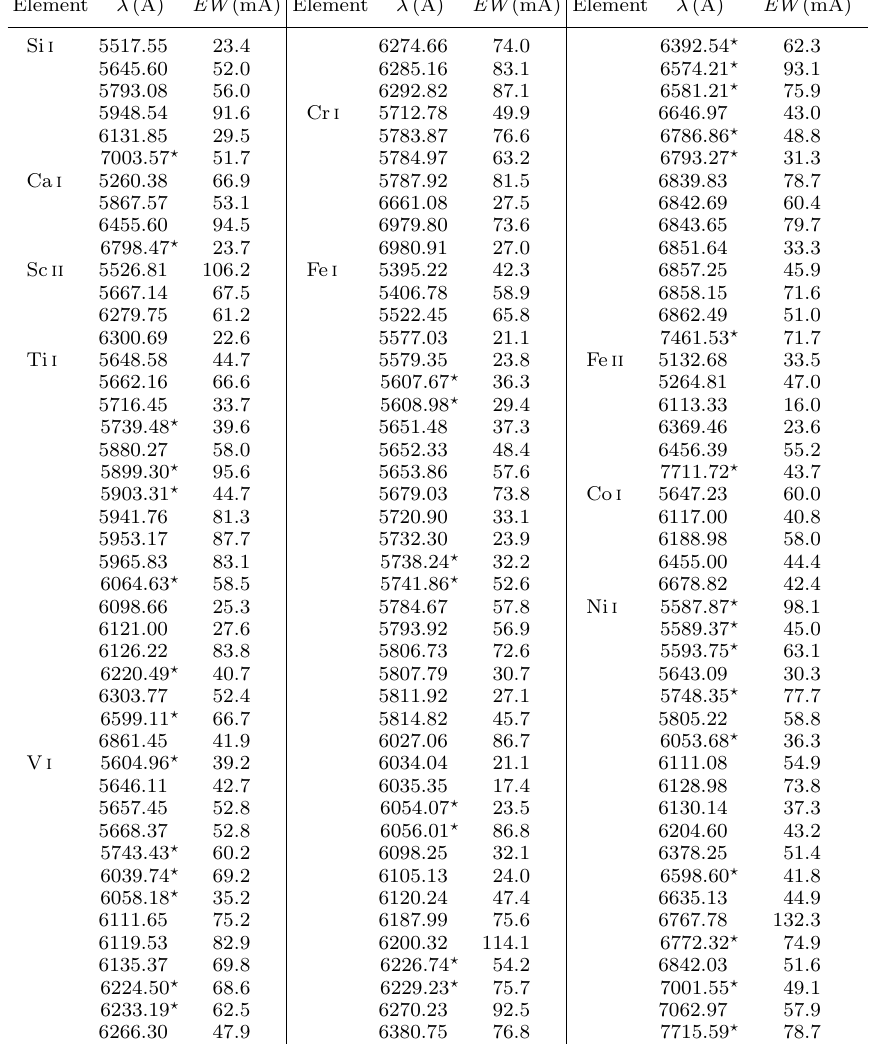
Table 1. Equivalent widths of lines, EW , in the spectrum of 33